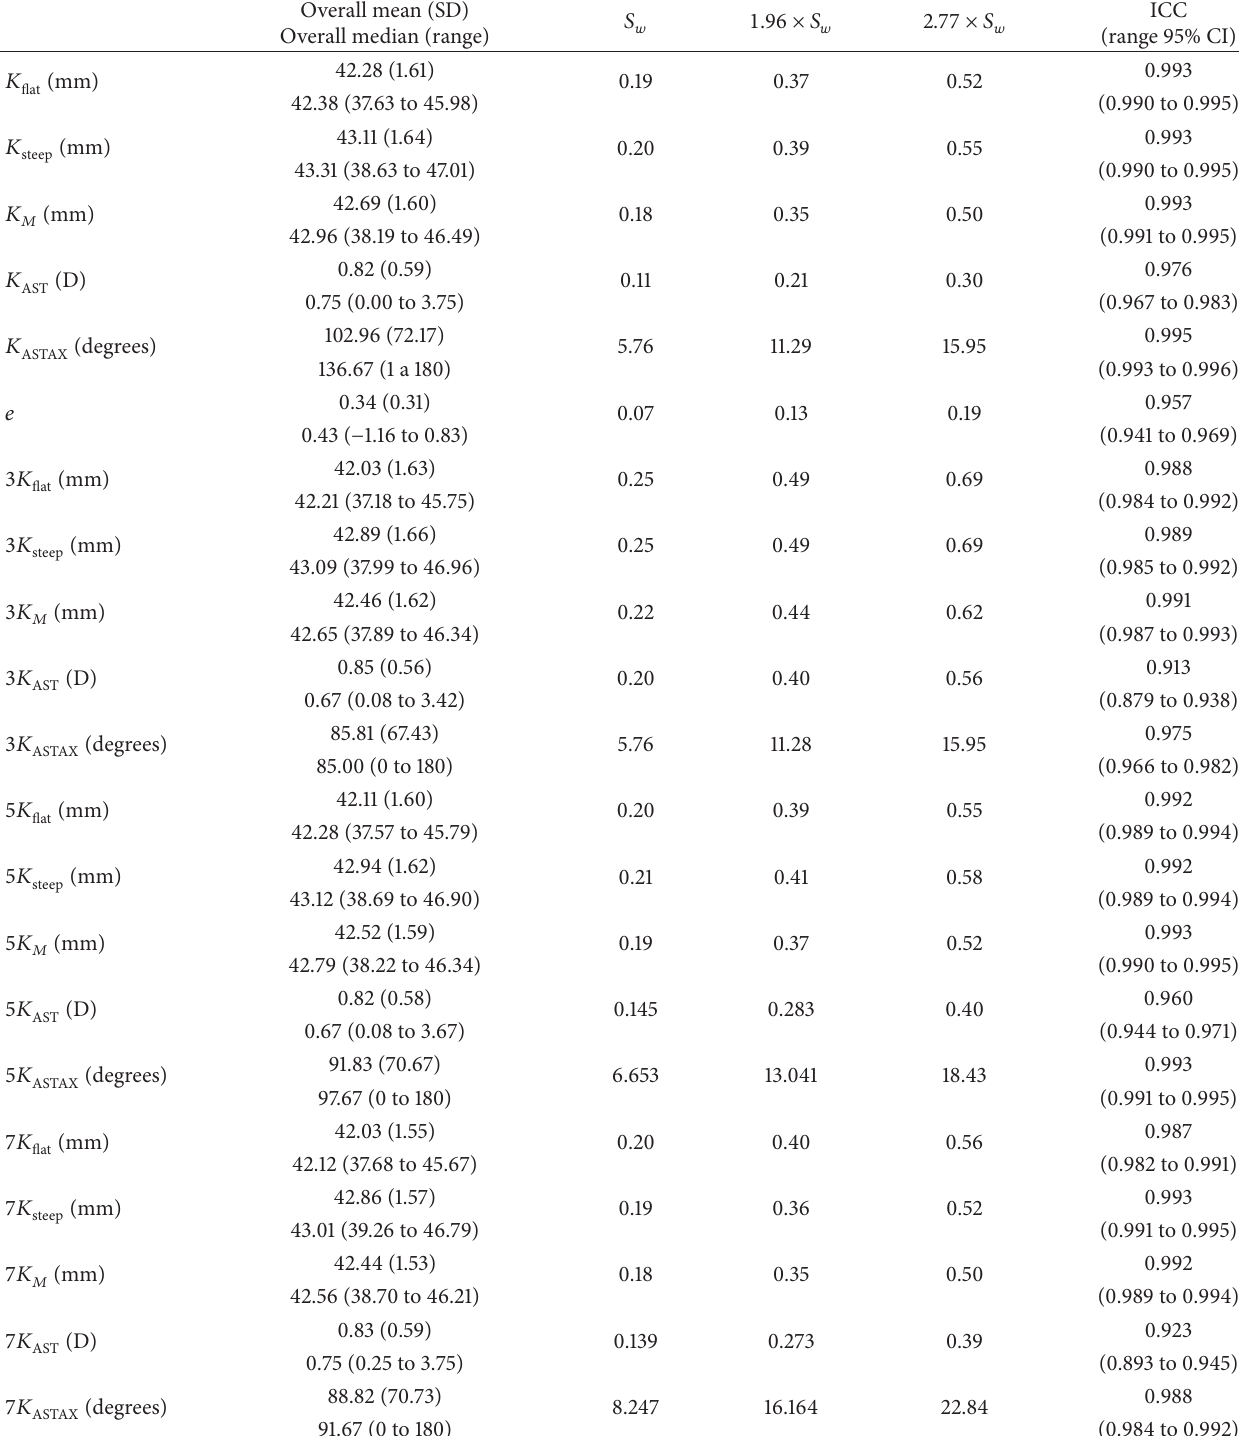
Table 1: Summary of the intrasession repeatability outcomes for the corneal curvature and eccentricity measurements obtained by means of the VX120